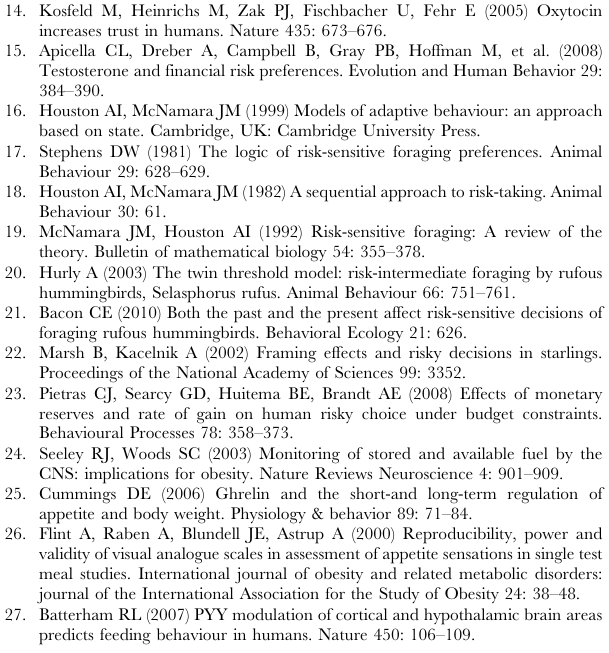
Figure S1 Schematic of risk-attitude changes in relation to a reference point (either for money or for food/energy). Risk- attitude equates to the curvature of this relationship. Below reference point, risk-seeking behaviour is seen. Near the reference point, decisions are risk-neutral (insensitive to risk). As energy or wealth increases, increasing risk-aversion is seen. At very high levels (e.g. repletion or satiation), this relation saturates and we again see risk-neutral behaviour. Note: Above the reference point, the relationship between wealth/energy and utility/fitness is marginally decreasing (concave), engendering risk-aversion. This